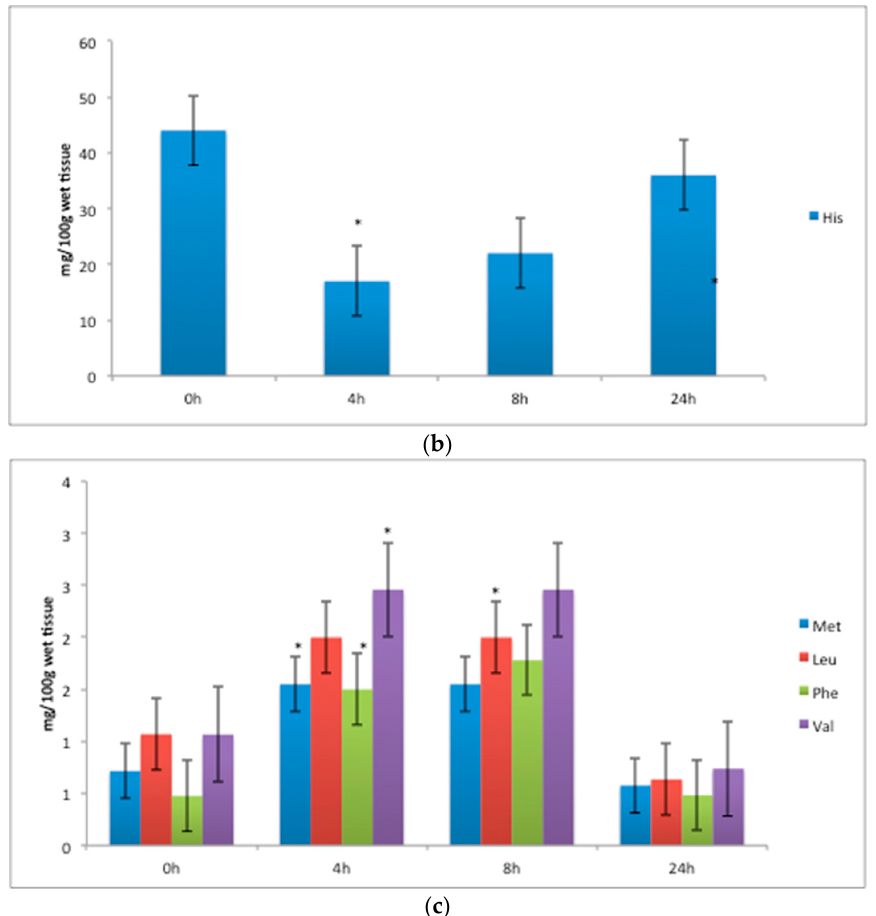
Figure 1. Essential white muscle free amino acid (FAA) concentration (mg/100 g wet tissue): ( a ) threonine and lysine, ( b ) histidine and ( c ) methionine, leucine, phenylalanine and valine before (t = 0 h) and after feeding (4 h, 8 h, 24 h) with the laboratory experimental diet. Data are expressed as mean ± SE, n = 9 fish per time point. The asterisk above bars indicates that there are statistically significant differences among the time after feeding ( p < 0.05).